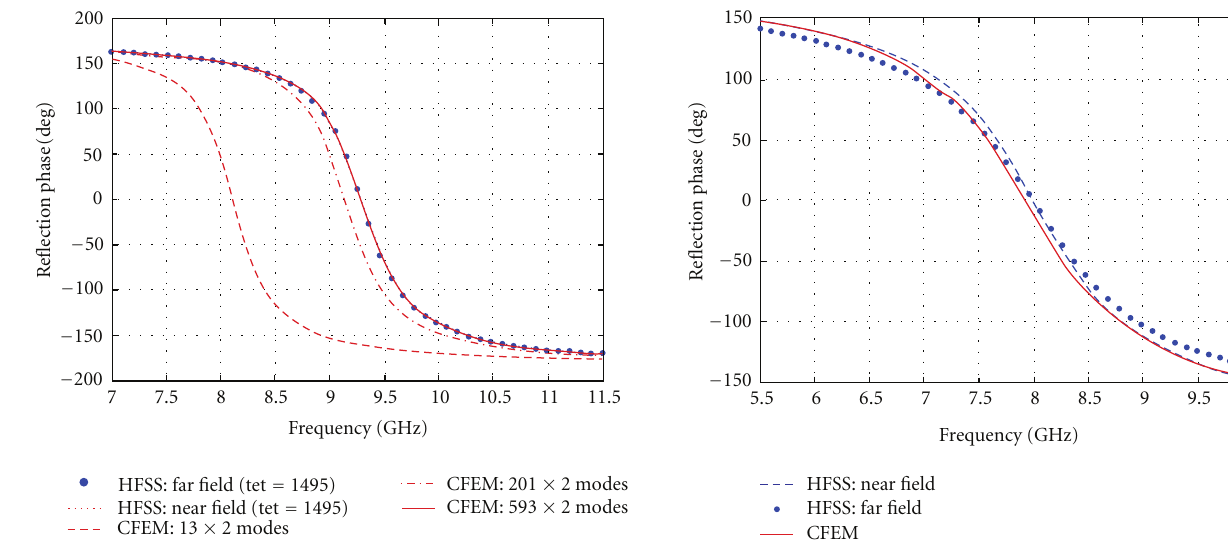
Figure 10: The reflection phase of the square patch AMC in Figure 6, for TM oblique incidence at θ = 150 ◦ , φ = 90 ◦ is shown and compared with the results obtained using HFSS (near-field and far-field